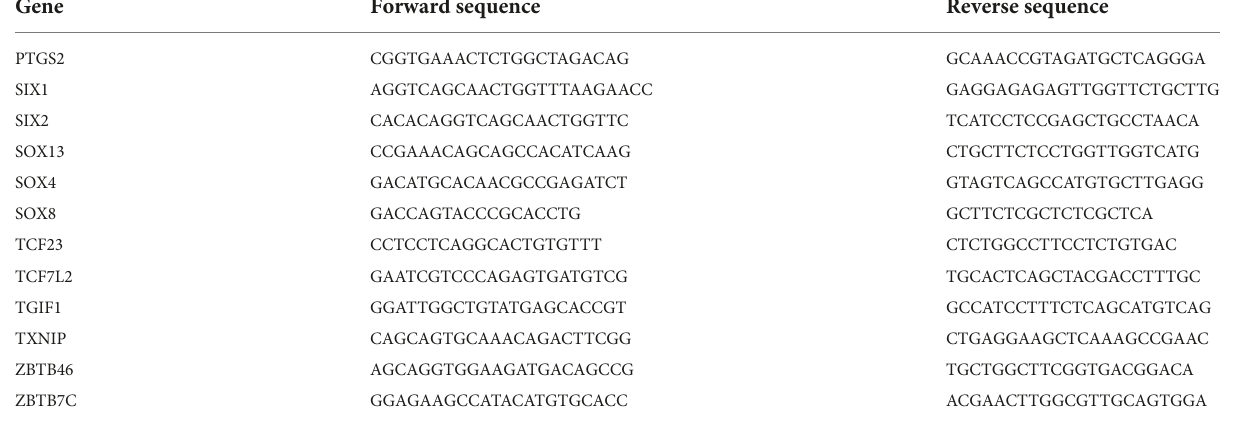
TABLE 3 Antibodies used for western blotting and immunostaining. Antibody Species Cat. No.